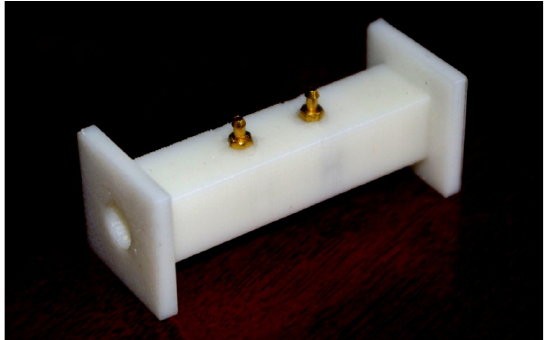
Figure 2. FPE prototype